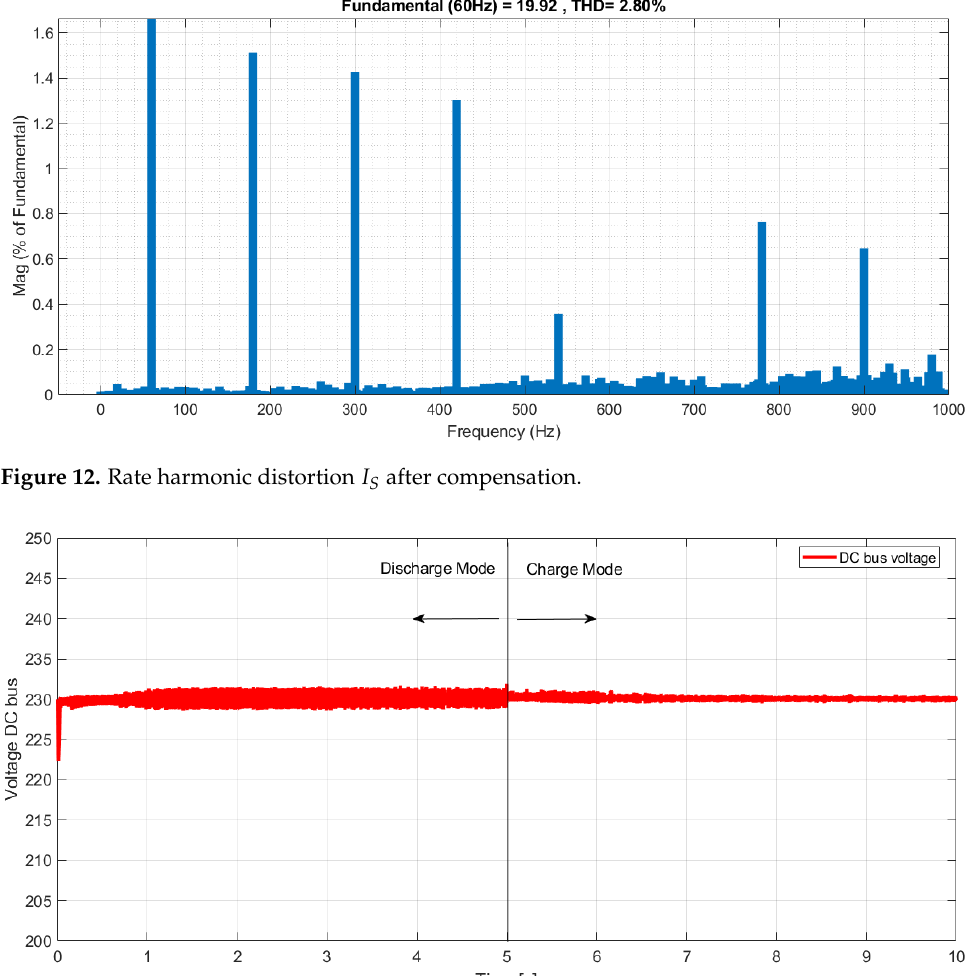
Figure 13. DC bus.